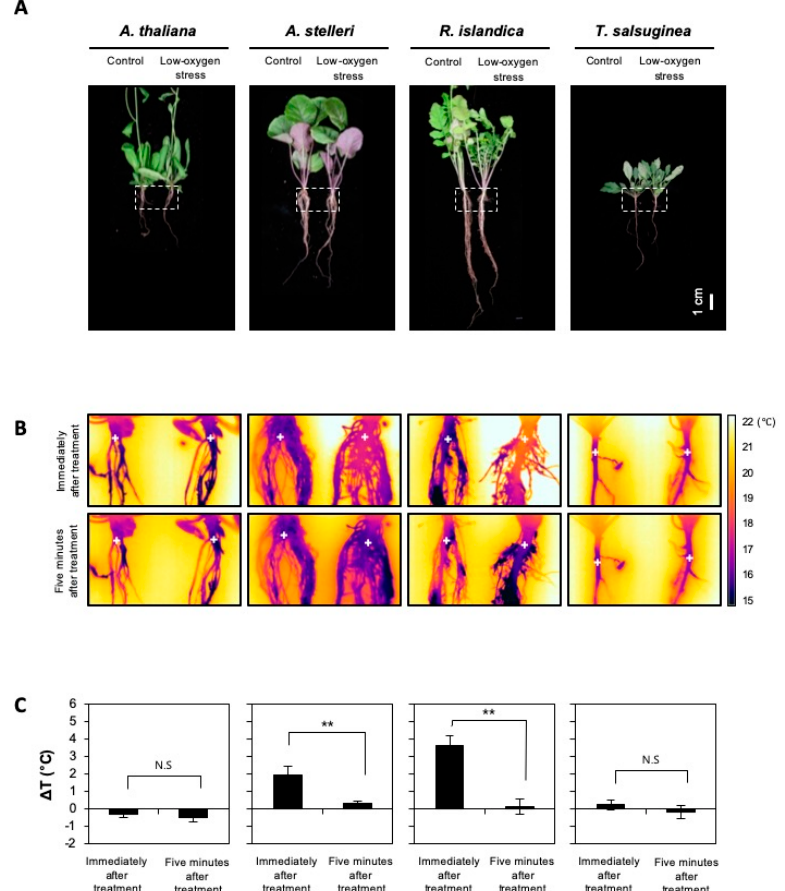
Figure 5. Changes in root temperature of the four species under low-oxygen stress. Five-week-old A. thaliana and closely related species were exposed to a low oxygen gas mixture (0.1% O 2 / 99.9% N 2 ) for 12 h. ( A ) Bright-field images of the four species. The dotted-line box indicates the position of an infrared image. ( B ) Infrared images of roots of untreated or low-oxygen-treated plants. The plus signs indicate temperature measuring positions. ( C ) Root temperatures were obtained from infrared images using ThermaCAM Quikplot software. Delta T ( ∆ T) is a change in temperature between the control and the low-oxygen-treated plants ( ∆ T = T test − T cont ). Bars represent the mean (three times) ± standard deviation. The level of statistical significance is also marked with one asterisk (*) if p < 0.05, two (**) if p < 0.01, three asterisk (***) if p < 0.001, and ns: not significant.